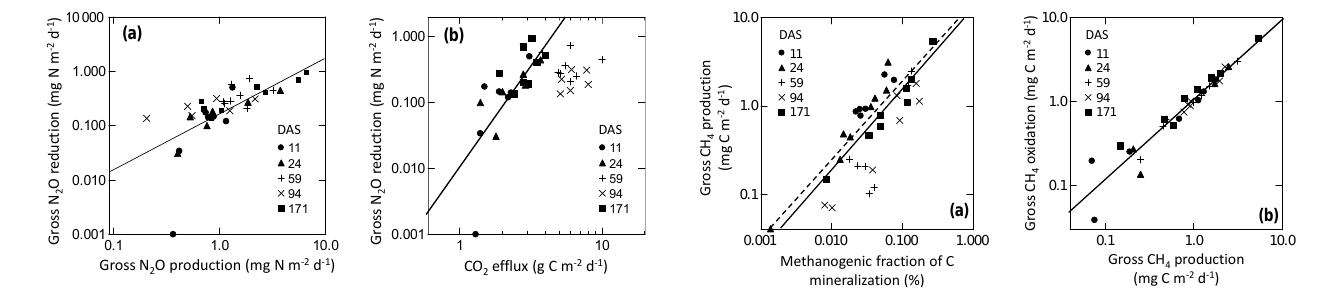
Figure 4. (a) Gross CH 4 production rates versus methanogenic fraction of C mineralization, and (b) gross CH 4 oxidation rates versus gross CH 4 production rates. Symbols represent sampling on different days after seeding (DAS): circles are DAS 11, triangles are DAS 24, pluses are DAS 59, crosses are DAS 94, and squares are DAS 171. The solid lines rep- resent the regression line for all sampling dates together, (a) Log 10 (y) = [18.953 × log 10 (x) ] + 2.245 ( R 2 = 0.40, n = 37, p< 0 . 001) and (b) Log 10 (y) = [1.308 × log 10 (x) ] − 1.028 ( R 2 = 0.67, n = 37, p< 0 . 001). The dashed line repre- sents the regression line for DAS 11, 24, and 171 only, Log 10 (y) = [22.681 × log 10 (x) ] + 1.904 ( R 2 = 0.60, n = 23, p< 0 .